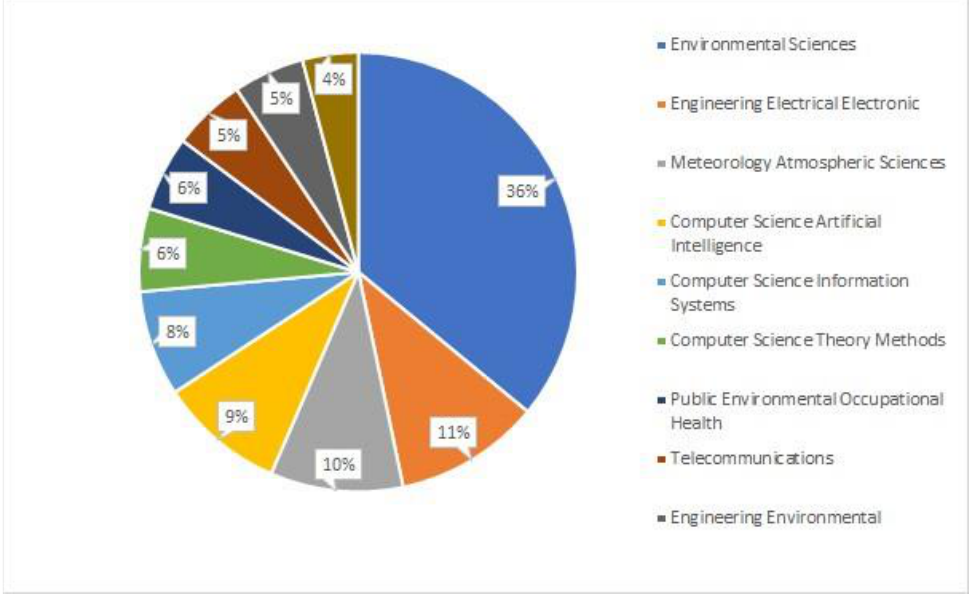
Figure 3. Different research areas with publications on “Air pollution and machine learning” .